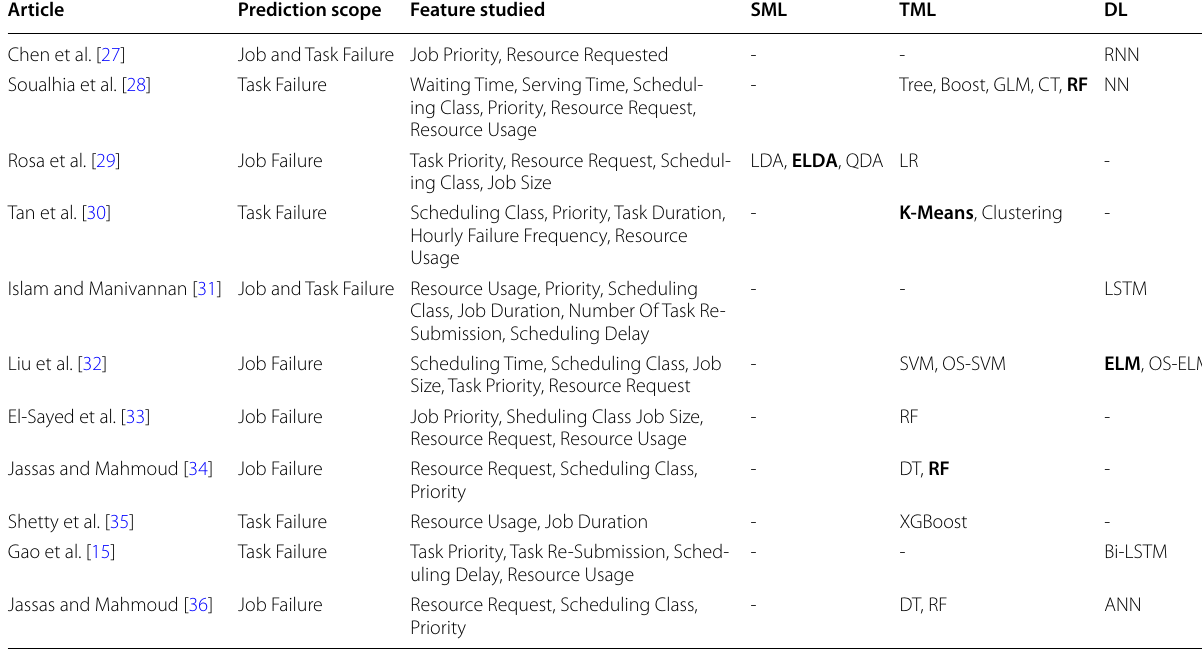
Table 8 This table presents the related works of job and task failure prediction using GCT dataset. The algorithm in bold refers to the best model mentioned in the respective article. [Note: SML ‑ Statistical Machine Learning Algorithms, TML ‑ Traditional Machine Learning Algorithms, DL ‑ Deep Learning